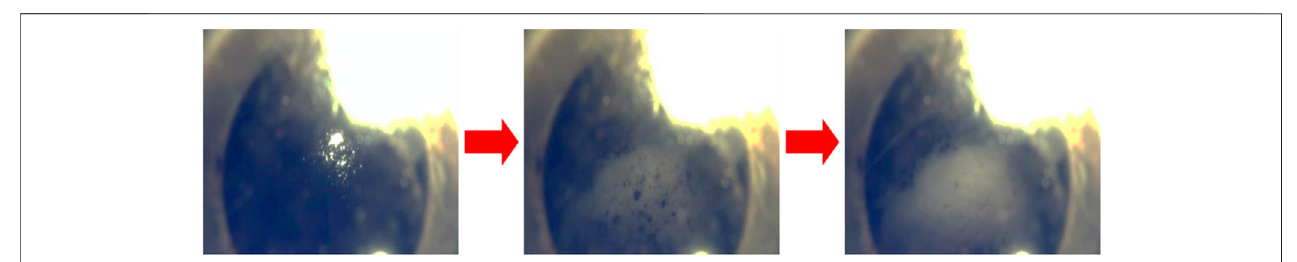
FIGURE 2 | Experimental phenomena of methane hydrate